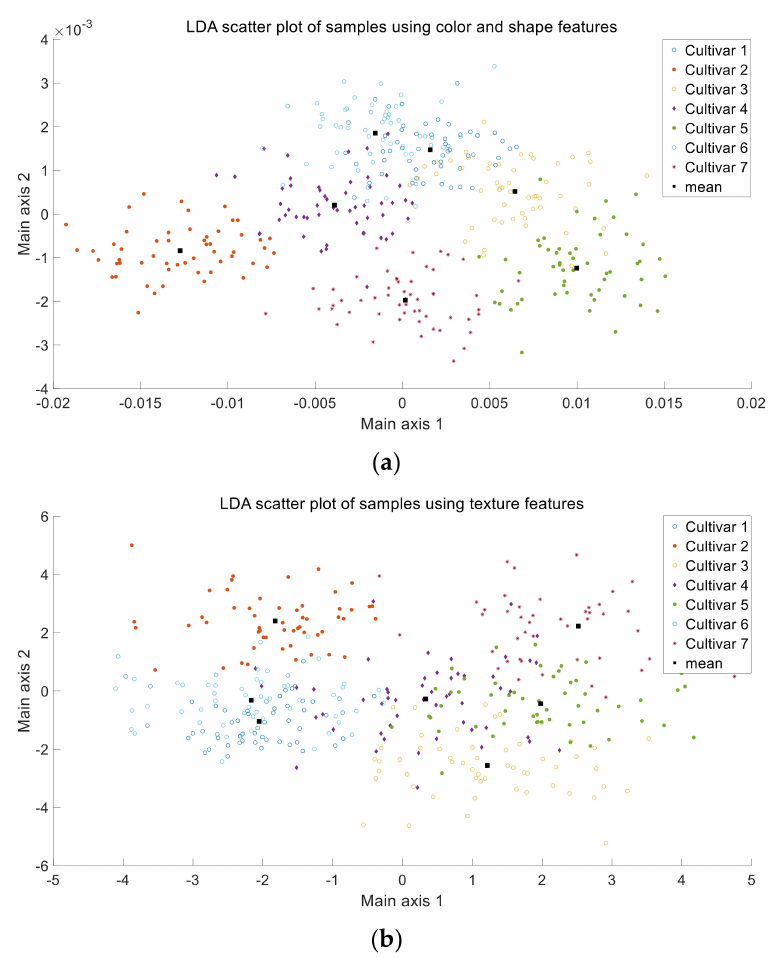
Figure 5. ( a ) Linear discriminant analysis (LDA) scatter plot of samples using color and shape features, ( b ) LDA scatter plot of samples using texture